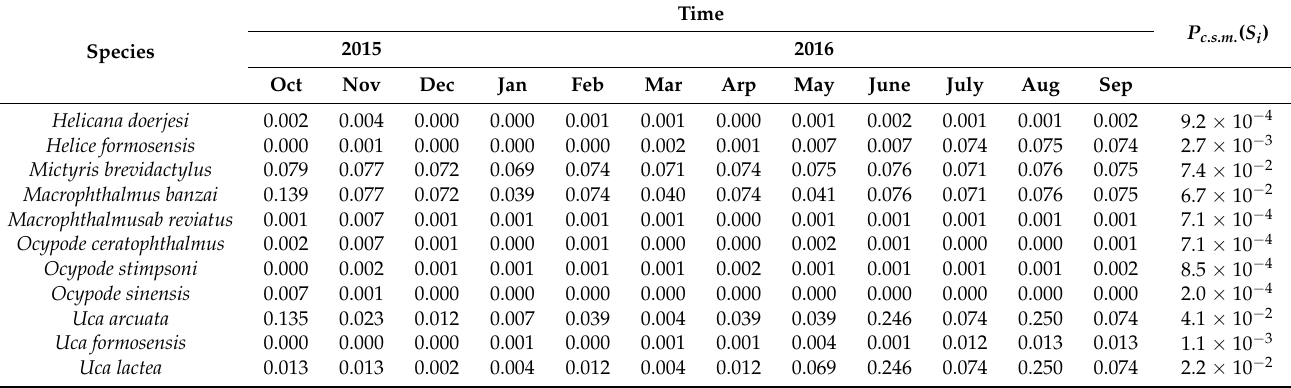
Table 1. The conditional co-occurrence probabilities of crab species in different